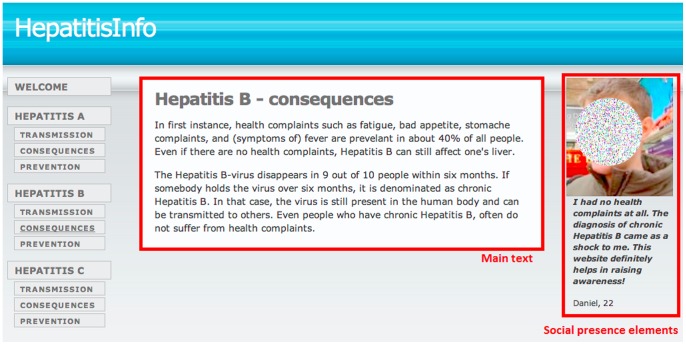
Example of lookzones on a page (image has been blurred to ensure anonymity).